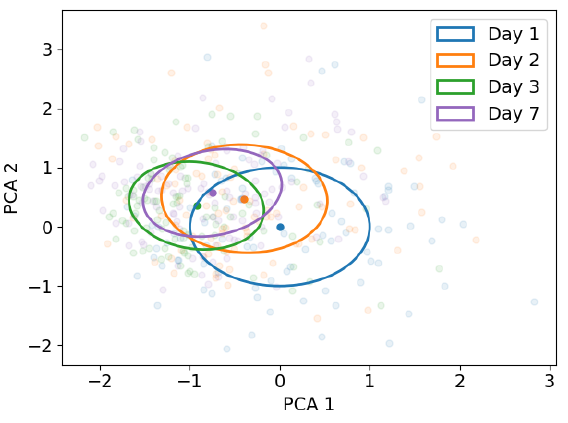
Figure 7. Average forward prediction error rates over all subjects per day per strategy during ramp ascent ( A ) and ramp descent ( B ).